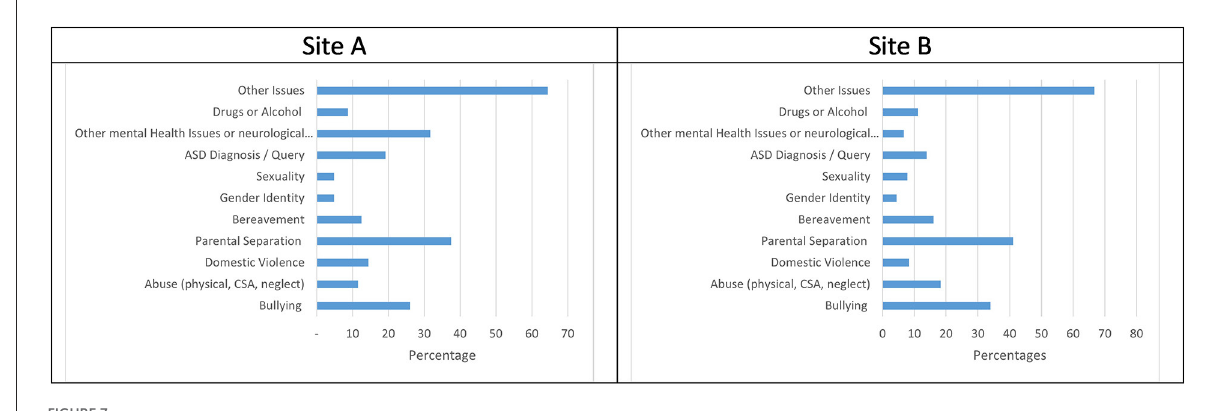
FIGURE7 (A,B) Underlying issues.